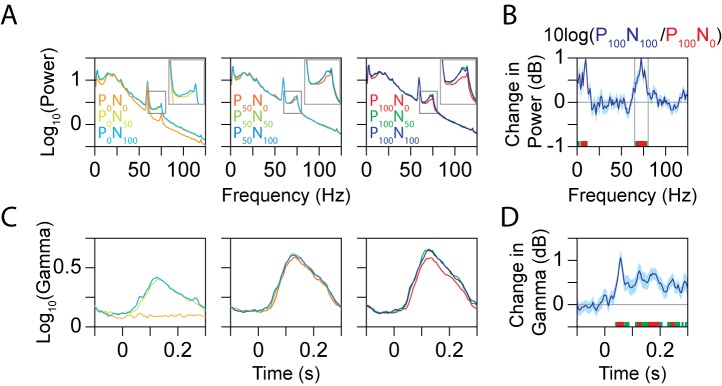
LFP power as a function of frequency and time.(A) Power spectra for different normalization conditions. (B) Change in power when both preferred and null stimuli are presented at 100% contrast (P100N100) versus when only a preferred stimulus is presented (P100N0). The shaded area represents the SEM. The frequency bins for which the change is significantly different are indicated by green (p<0.01, no Bonferroni correction) and red (p<0.05, Bonferroni corrected) squares at the bottom of the plot. Gray lines indicate the gamma range. (C) Gamma power (65–80 Hz, excluding 74–76 Hz) as a function of time, for different normalization conditions (same convention as A). (D) Change in gamma power between P100N100 versus P100N0 condition as a function of time (same convention as B).